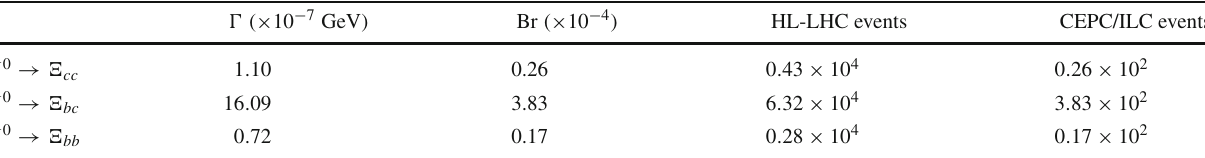
, (cid:4) bc (cid:5)[ 3 S 1 ] ¯ , (cid:4) bc (cid:5)[ 1 S 0 ] ¯ , (cid:4) bb (cid:5)[ 1 S 0 ] 6 and (cid:4) bb (cid:5)[ 3 S 1 ] ¯ 3 3 / 6 3 / 6 3